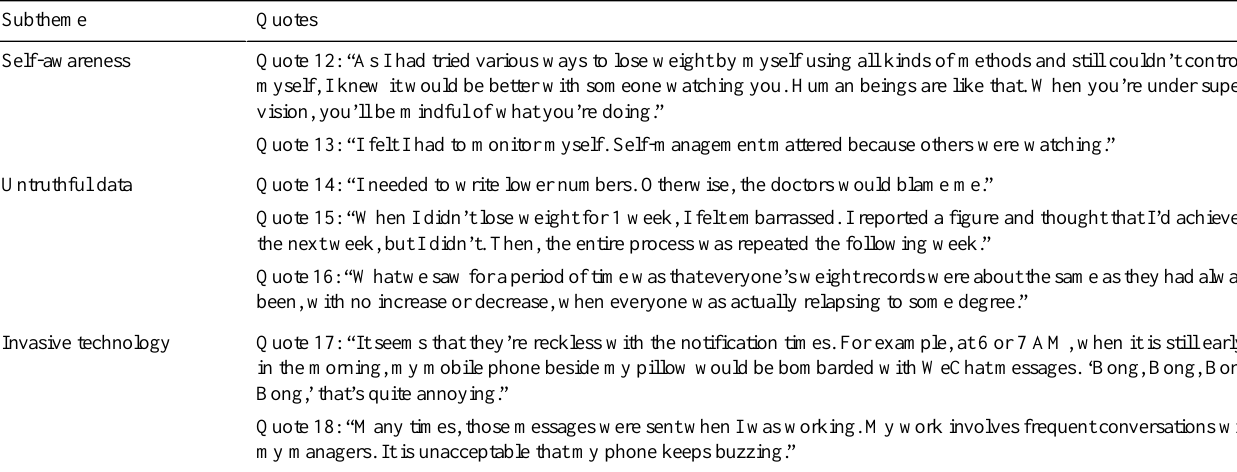
Table 2. Supporting quotes for theme 2: Cooperation and resistance to surveillance. QuotesSubtheme